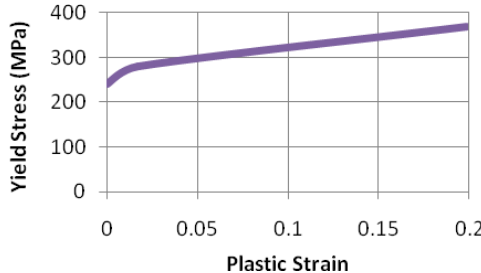
Fig. 2. Yield stress versus plastic strain.